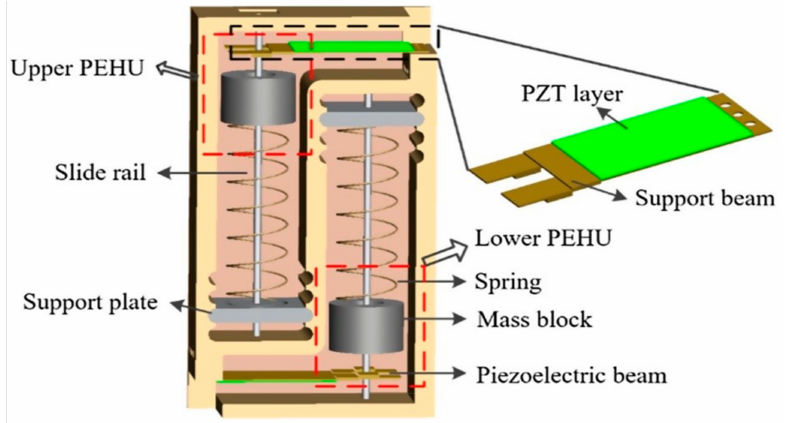
Figure 13. Geometry of the proposed energy